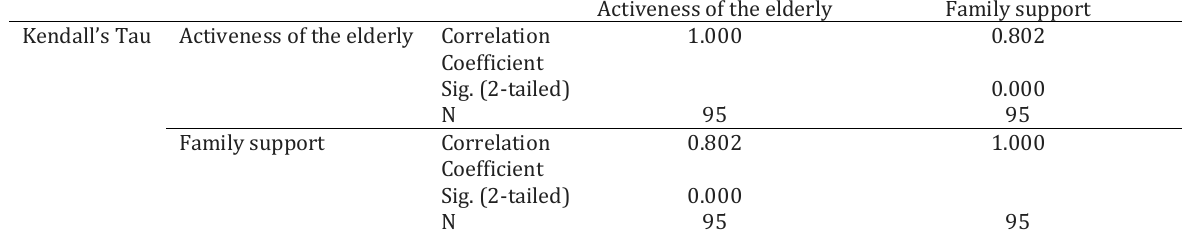
Table 2.Analysis